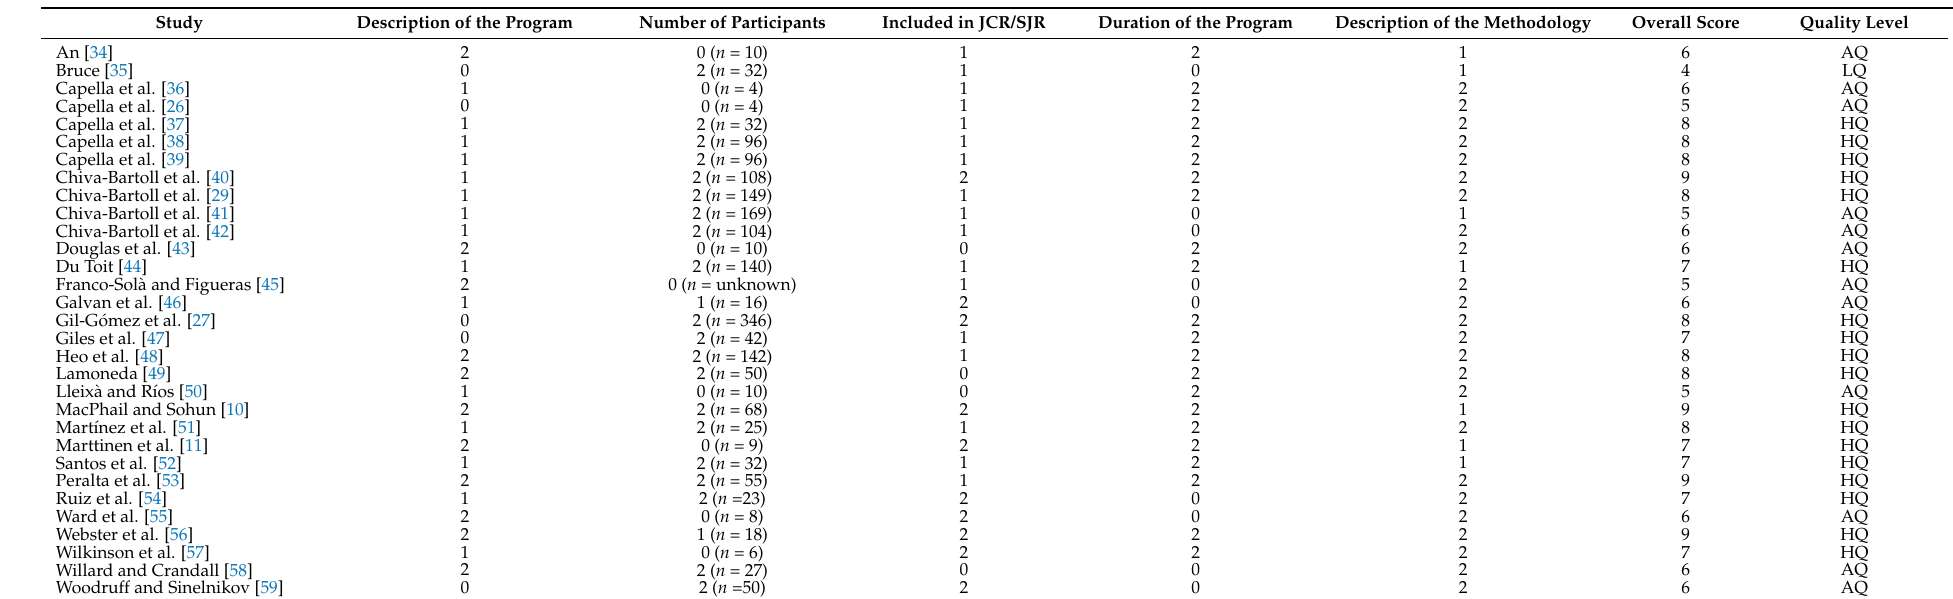
Table 1. List of studies included and quality